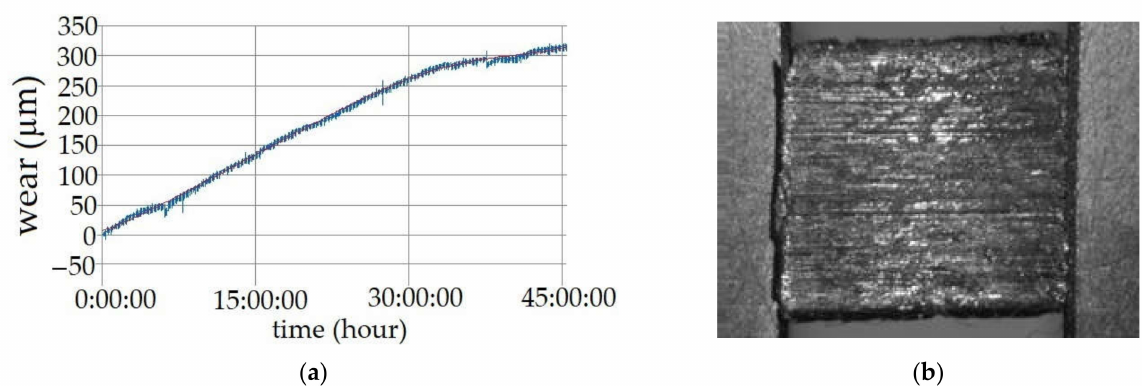
Figure 12. ( a ) The time dependence of the wear size of the testing specimen of the welded material S960 QL by MAG technology. ( b ) The macrostructure of the friction surface of the testing specimen after the tribological